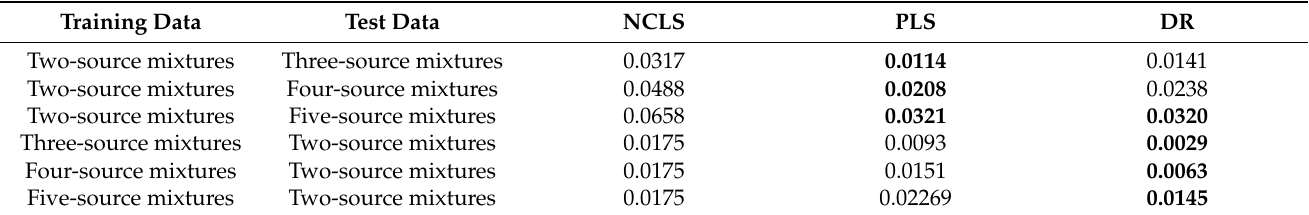
Table 5. Robustness analysis results for “high-mixing-rate mixture” dataset (Mixing-rate range used for synthesizing